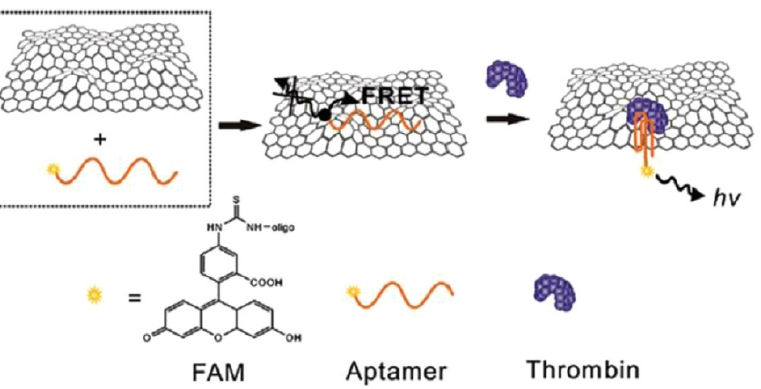
Figure 10. Schematic representation of fluorescence-based detection. Reproduced from Reprinted with permission from Ref. [155]. Copyright 2017, Elsevier.